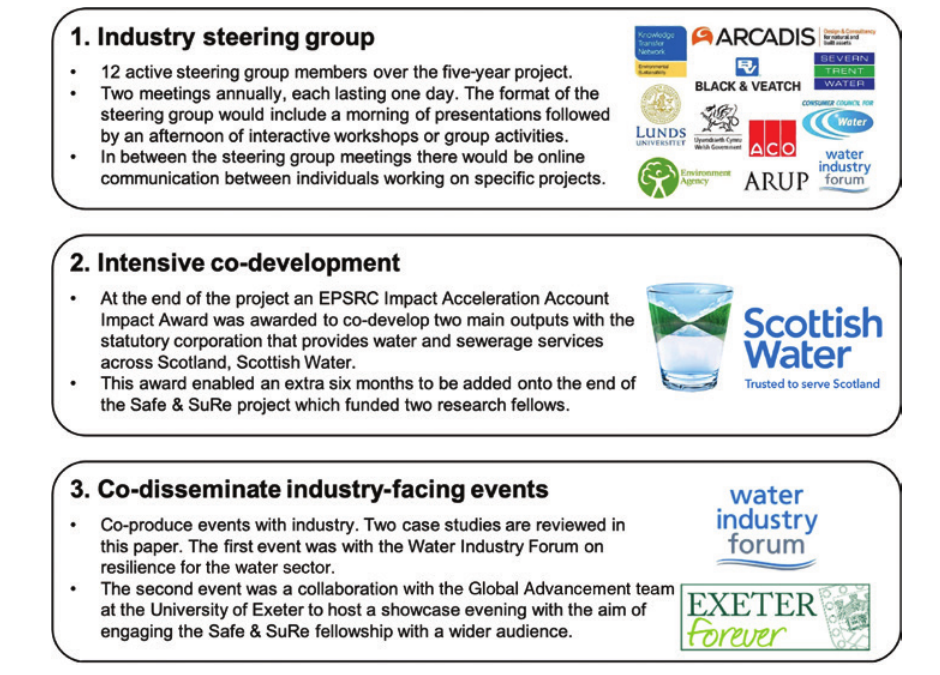
figure 1: overview of the main co-production activities discussed in this